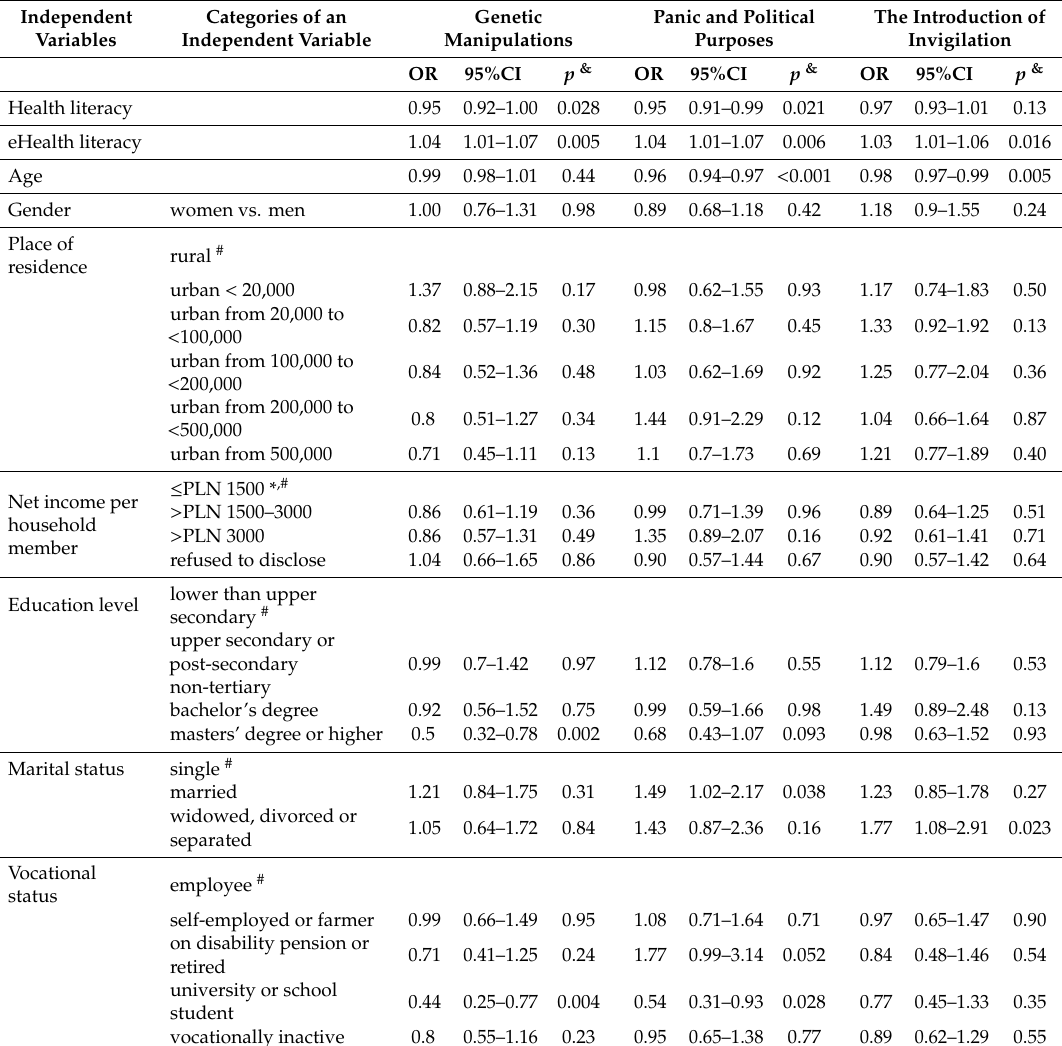
Table 3. Logistic regression models for dichotomised variables reflecting views on individual conspiracy theories included in the